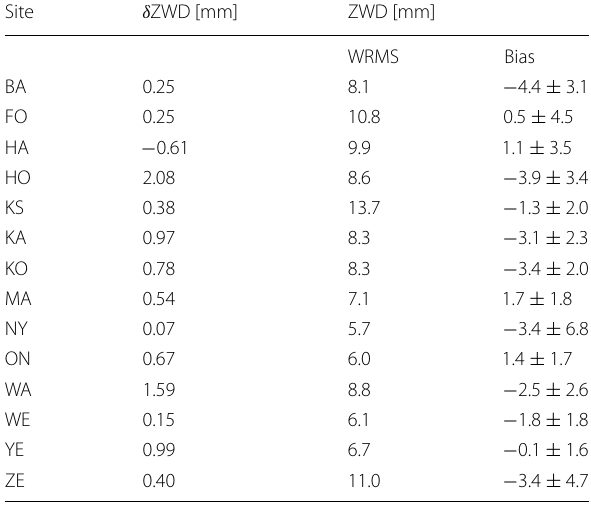
The statistics are calculated based upon 15 daily single-technique solutions. Both δ ZWD and biases are expressed w.r.t. the VLBI-derived parameters